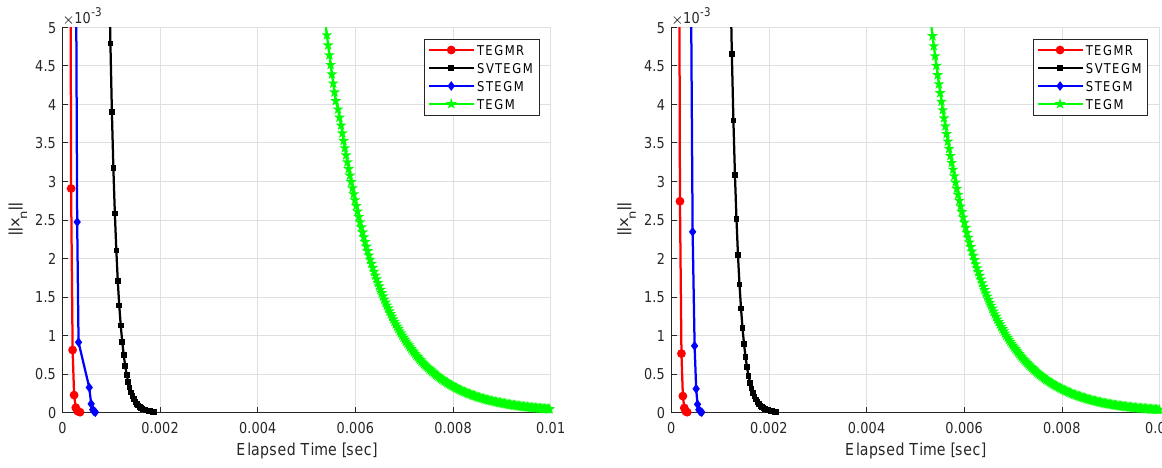
Figure 1. Example 3, ( left ): Case I and ( right ): Case